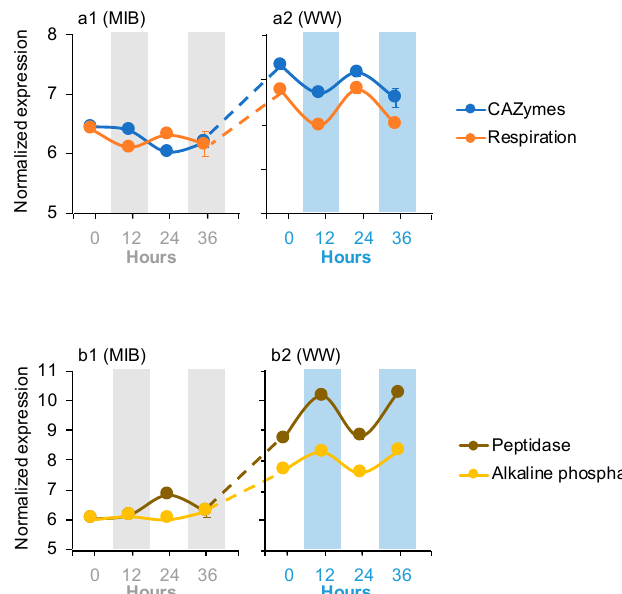
Figure 3. Averages of the normalized microbiome gene expression values based on variance stabilizing transformation in DeSeq2 related to ( a ) carbohydrate-active enzymes and microbiome organism respiration, and ( b ) peptidases and alkaline phosphatase. Gray bars and blue bars indicate dark condition samples in the MIB and WW, respectively. The error bar represents the standard error of the gene expression